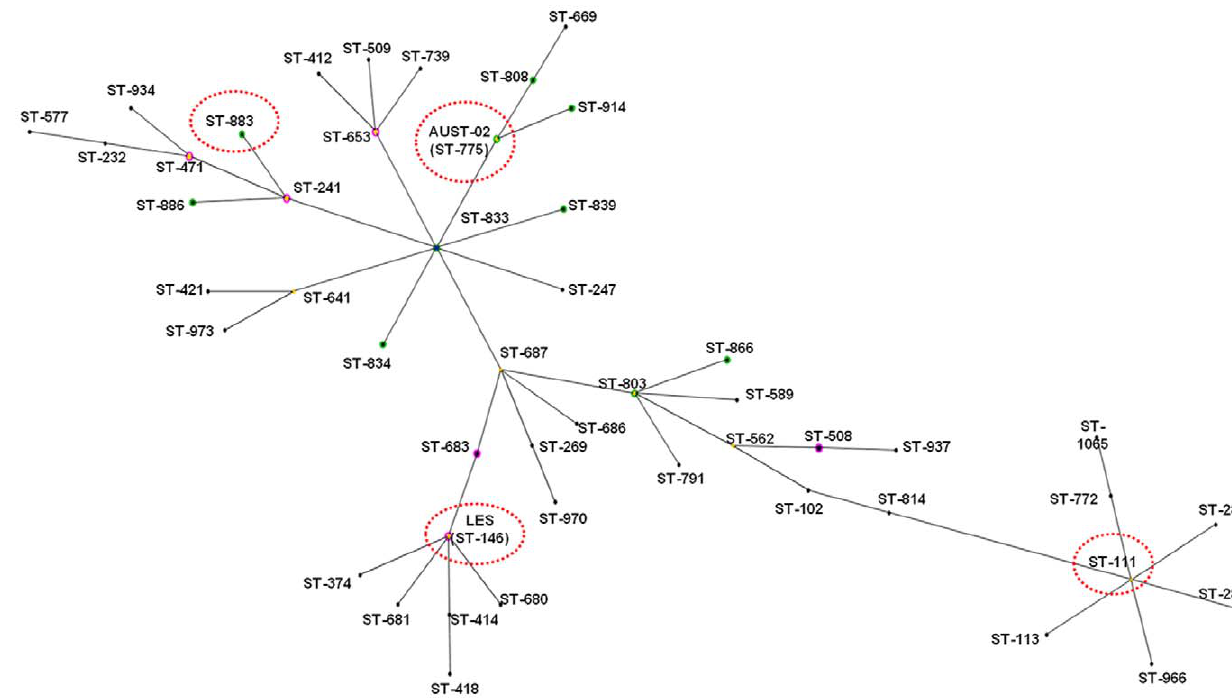
Figure 7. eBURST diagram showing BURST Group 01 when all 1070 sequence types listed on the Pseudomonasaeruginosa PubMLST database (October 2011) were analysed. Dots represent sequence types (STs), and lines connect single-locus variants. The diagram shows all ancestral founders (blue STs) and subgroup founders (yellow STs). STs with green halos were detected in the current study only; STs showing pink halos were detected in the current study and elsewhere; STs with no halo were not detected in the current study. Line length is arbitrary.